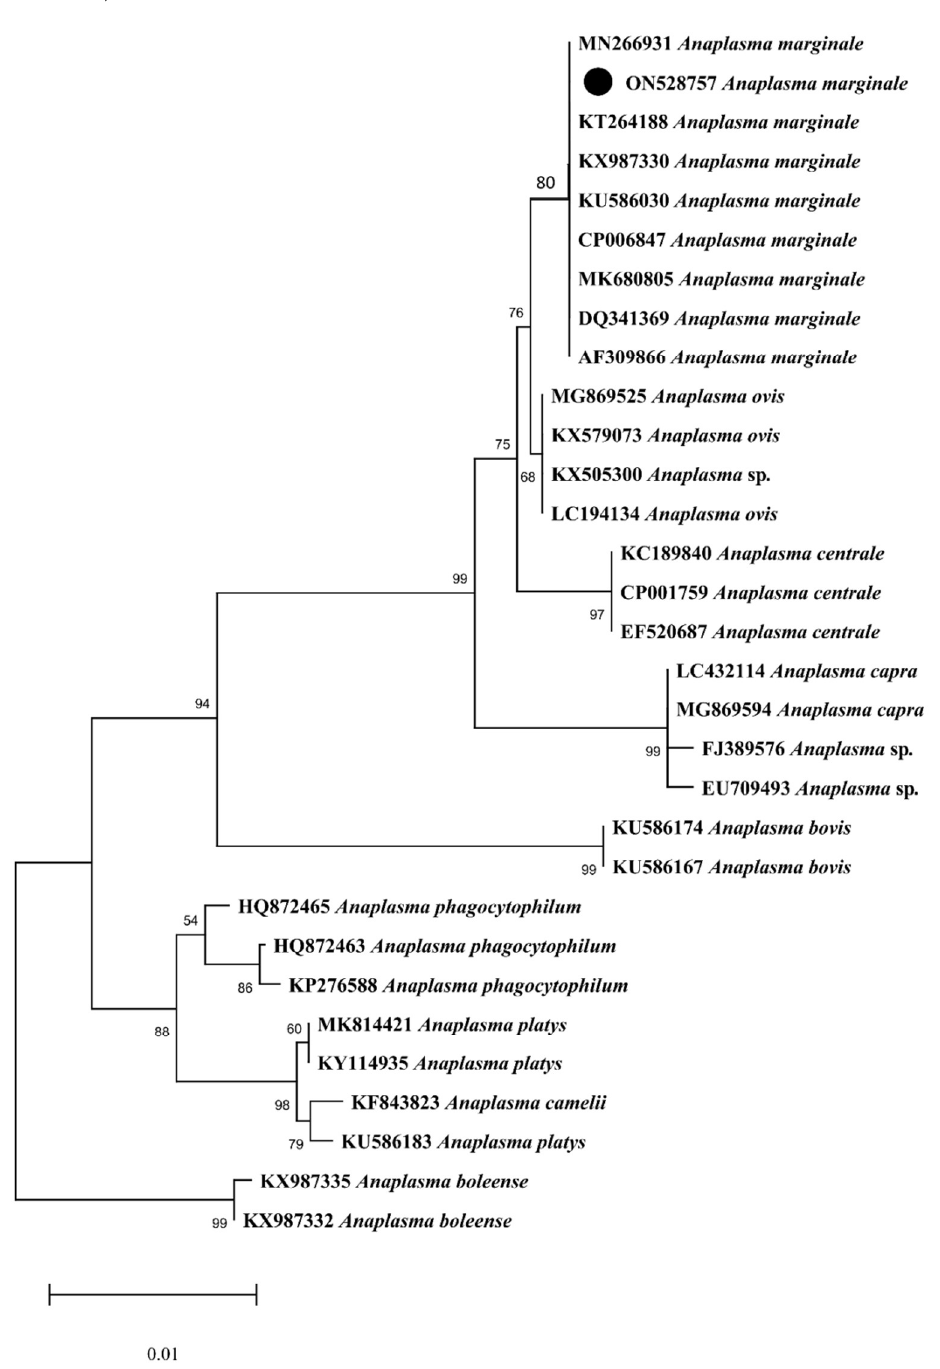
Figure 7. Maximum likelihood phylogenetic tree based on the partial 16S rRNA sequence of A. mar- ginale . The Anaplasma boleense was used as an outgroup, using supporting values (1000 replicons) at each node. The scale bar indicates the number of substitutions per site. The obtained sequence was represented with a black circle.